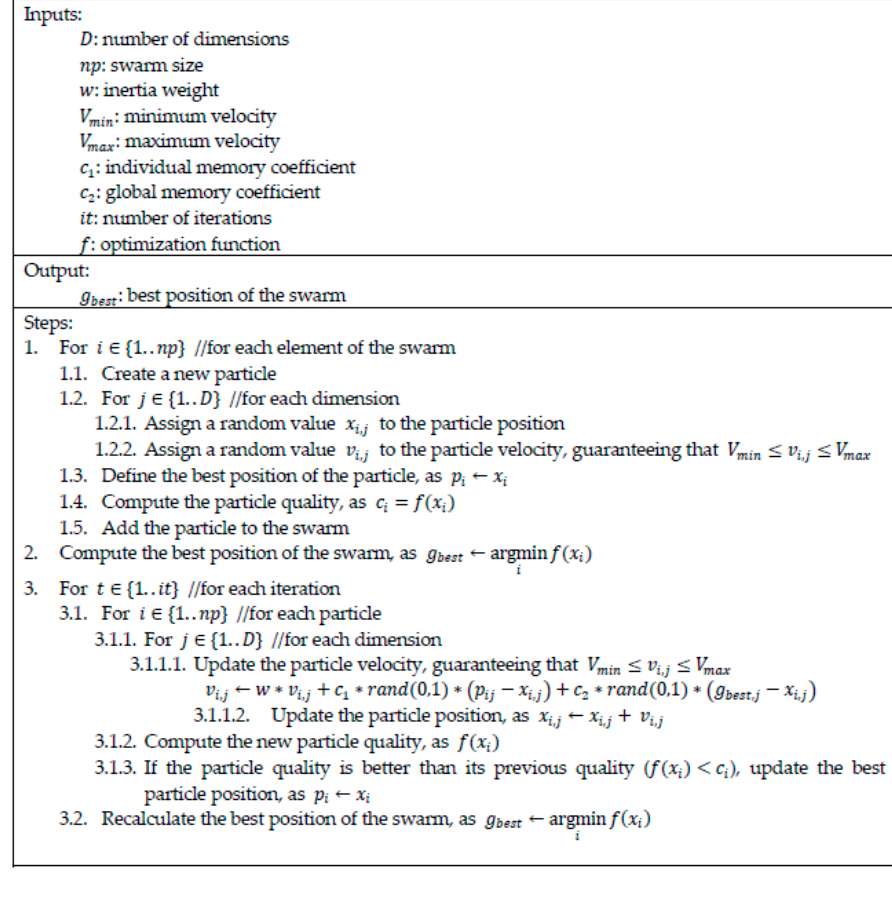
Figure 1. Pseudocode of the PSO algorithm.